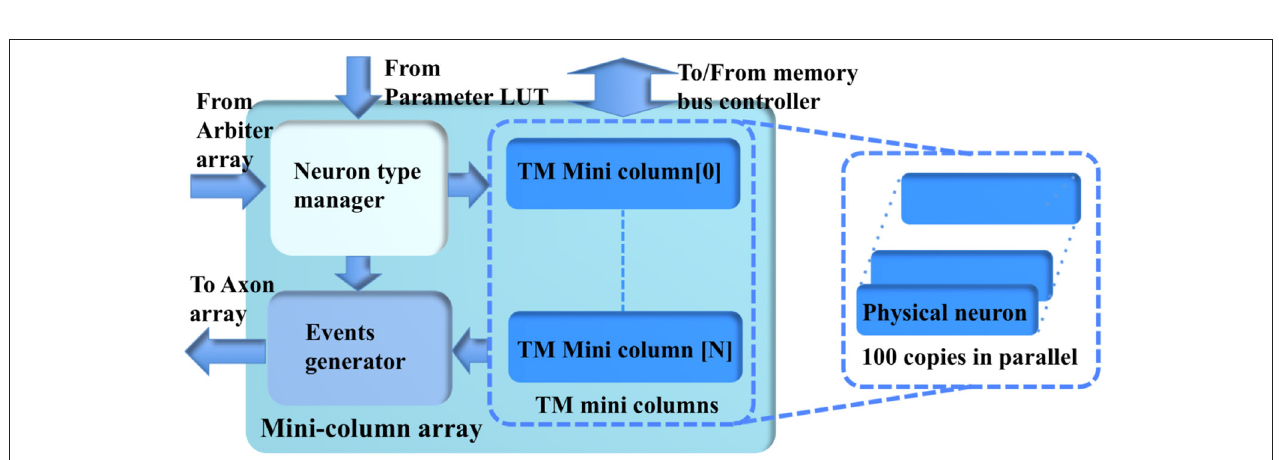
FIGURE 6 | The architecture of the cortex emulator. The system consists of a neural engine, a Master, off-chip memories, and a serial interface. The neural engine realizes the function of biological neural systems by emulating their structures. The Master controls the communication between the neural engine and the off-chip memories, which store the neural states and the events. The serial interface is used to interact with the other FPGAs and the host controller, e.g., PCs.